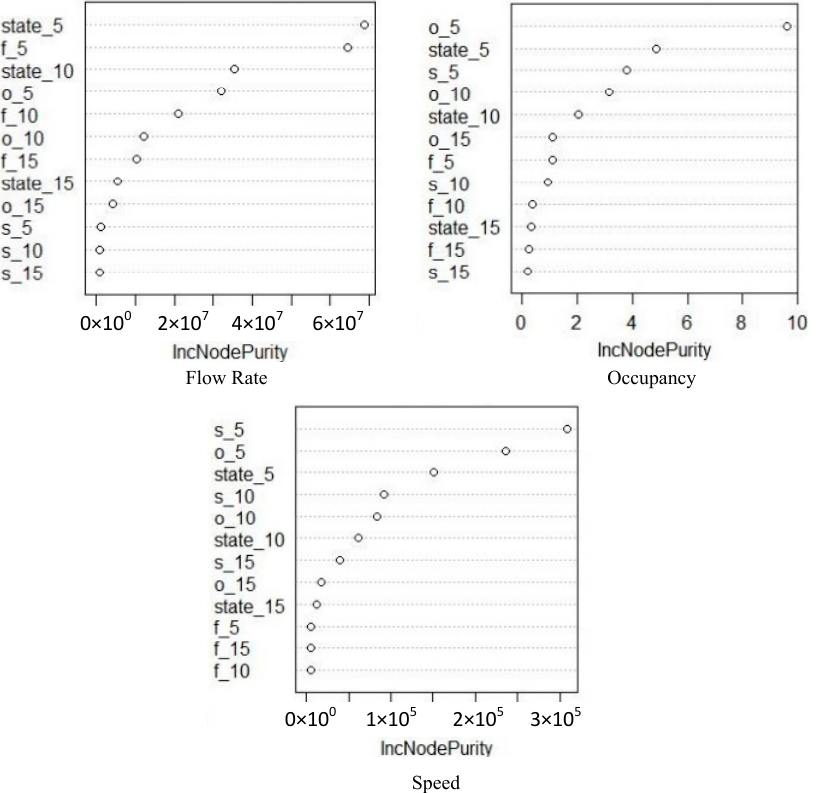
Figure 5. Feature importance associated with Station 400081.